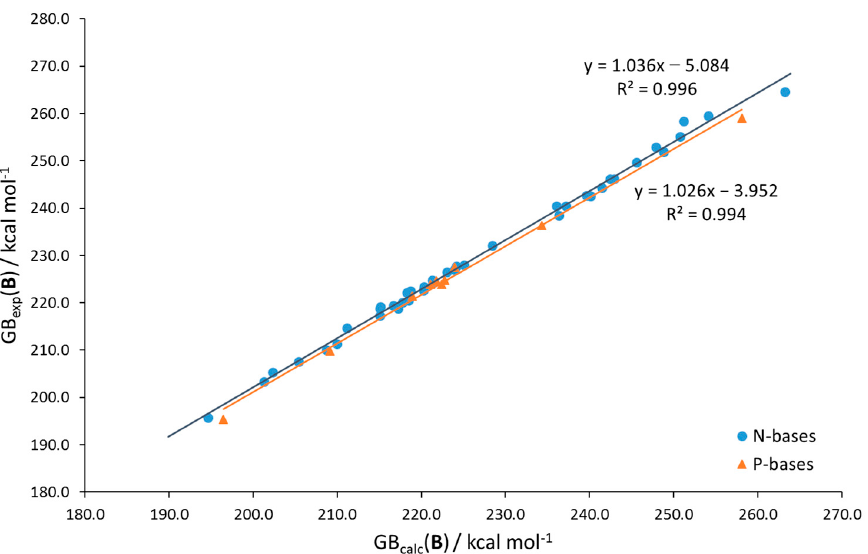
Figure 1. Correlation of the experimental against calculated GB values for a set of nitrogen bases (blues circles) and selected phosphines (orange triangles). All GB calc were calculated using the MP2(fc)/6-311+G(2df,p)//B3LYP/6-31G(d) approach (M6 model).